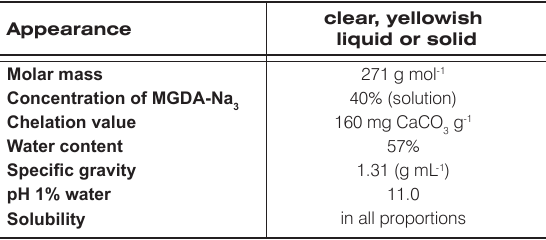
Table 2. Characteristics of MGDA